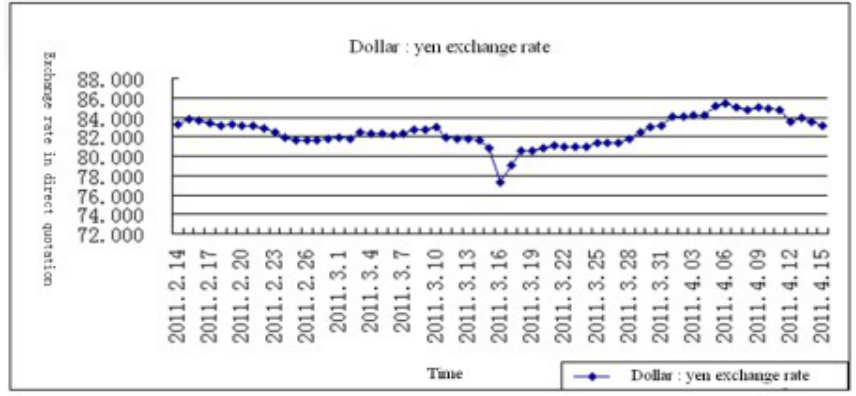
Figure 1. Chart of middle rate of dollar: yen exchange rate around Japan’s earthquake (Data source: State Administration of Foreign